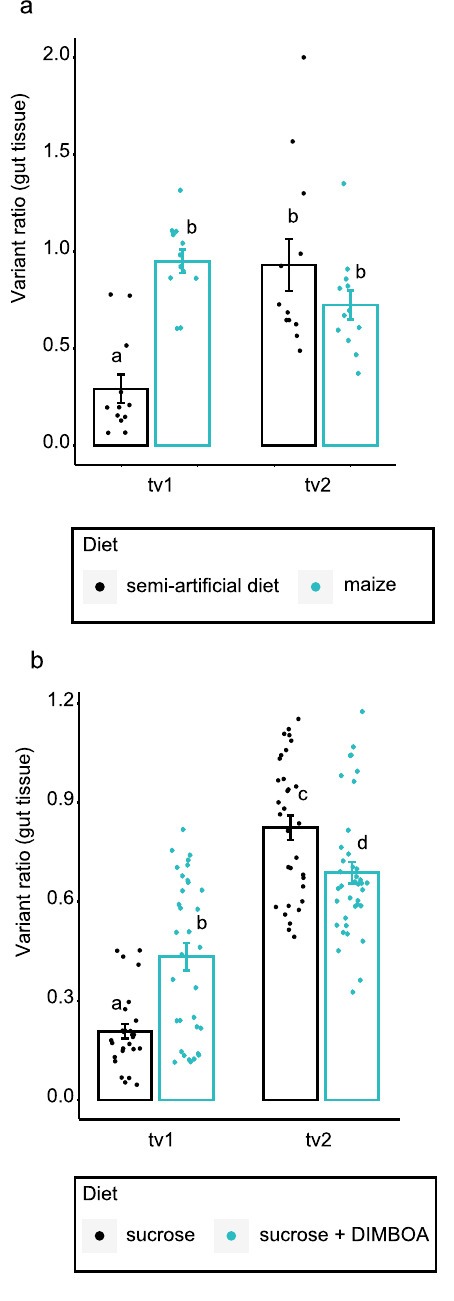
Figure 2. Real time PCR quantification of SfUGT33F28 variants tv1 and tv2 in FAW larval midguts after feeding on different diets. ( a ) After feeding on semi-artificial diet compared to maize leaves, ( b ) After feeding with sucrose only or 0.625 mM DIMBOA-solution in sucrose. All expression data are represented as ratios of variant transcripts relative to the full length canonical transcript. Data are presented as mean ± SEM (n = 12–15 for semi-artificial diet versus maize feeding, n = 30–40 for feeding on sucrose solution). All values were square root transformed to meet the criteria for normality. Two-way ANOVA was performed, and the Holm–Sidak method was applied to carry out pairwise comparisons ( a , b ). Small letters on the bars indicate significant differences at P <